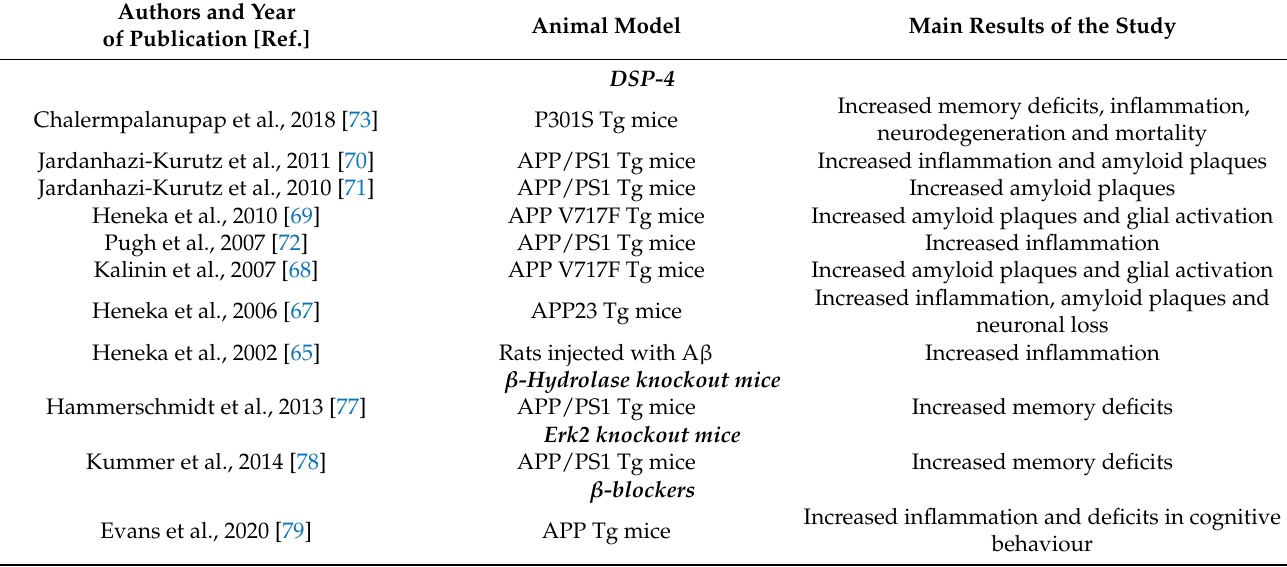
Table 2. Dysfunction of noradrenergic system in mouse